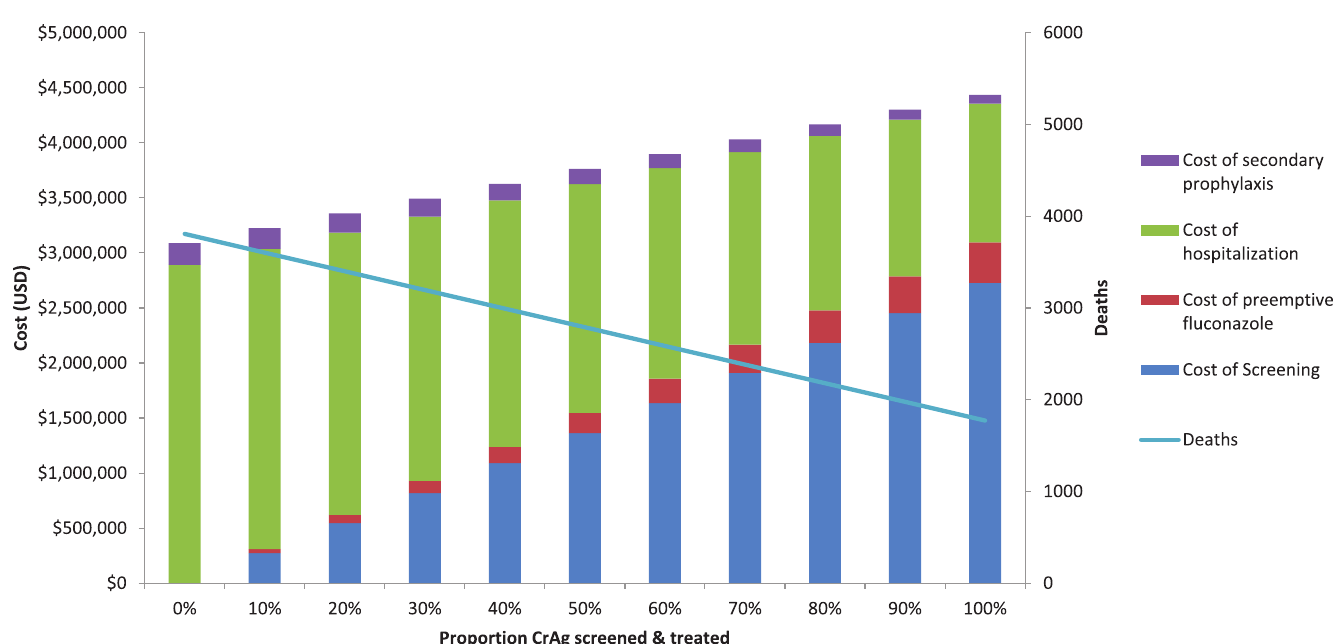
Fig 8. Cost of CrAg screening and preemptive treatment with differential levels of implementation with an HIV test-and-treat model. With 100% CrAg screening and treatment, 53% of deaths are averted at a cost of $662 per death averted.